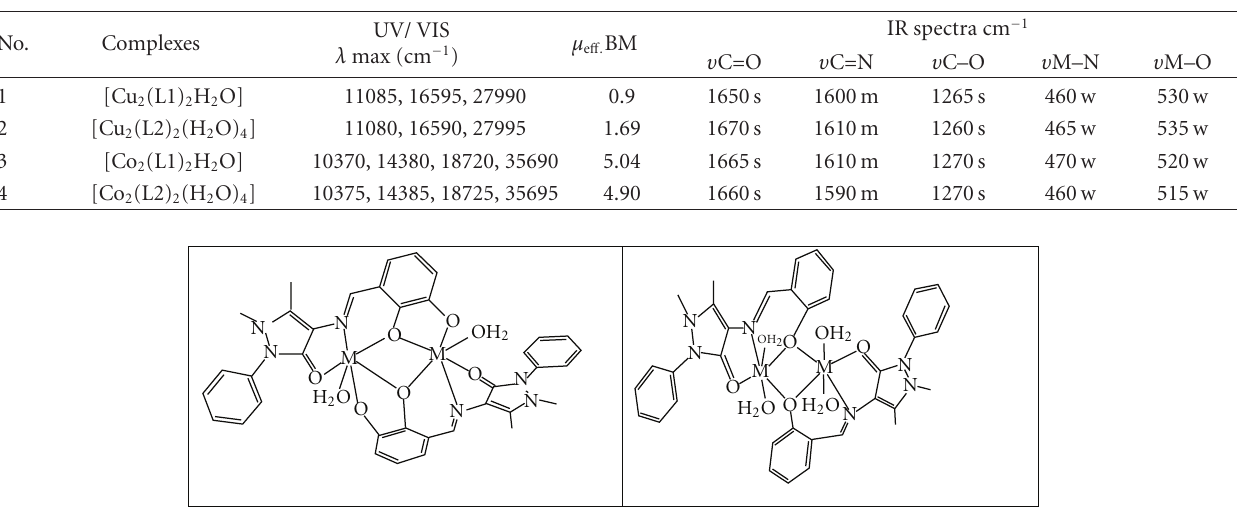
Figure 2: The proposed structure of the complexes where M = Cu(II) or Co(II)of the ligands L1 and